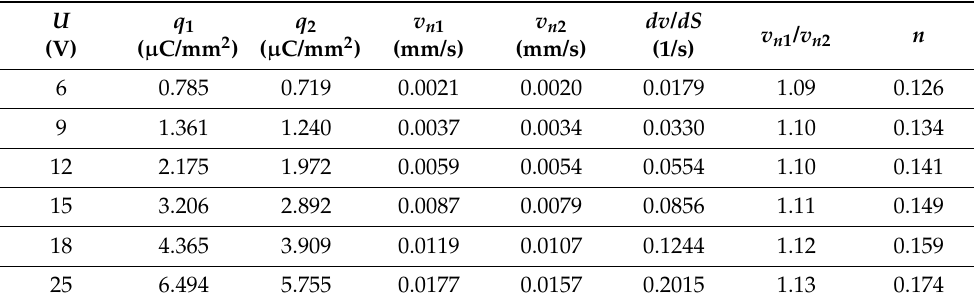
Table 2. Summary of calculations performed on the basis of the equation q ( S , U = const ) for 5%